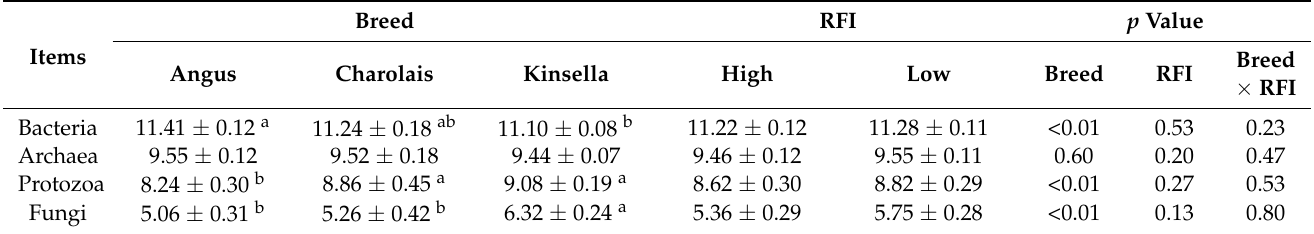
a,b Means with different superscripts in each row were significantly different ( p < 0.05); RFI, Residual Feed Intake.